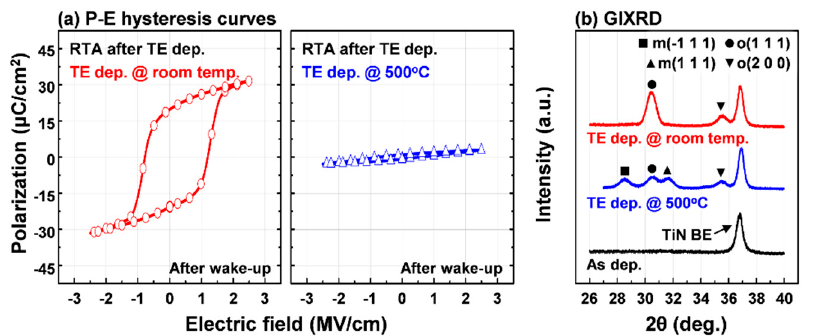
Figure 4. ( a ) The polarization-electric field hysteresis curves of 10-nm-thick HZO-based MIM capacitors with different deposition temperatures of TiN top electrodes; ( b ) GIXRD patterns of as-deposited HZO film and annealed HZO films after TiN top electrode deposition at room temperature and 500 °C, respectively.